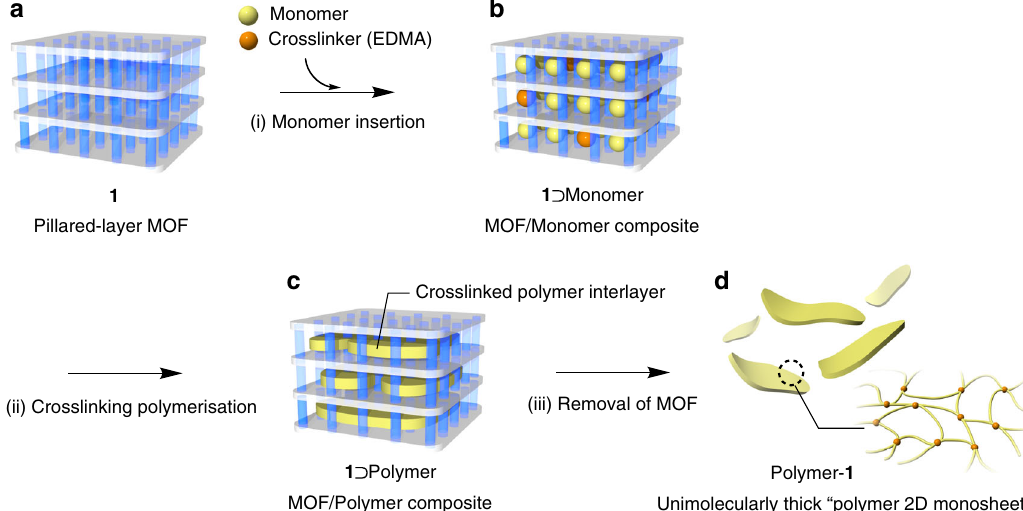
Fig. 1 Synthesis of polymer 2D monosheets using a pillared-layer MOF. a – d Schematically depicting the fabrication of ultimately thin polymeric sheets by crosslinking polymerisation in a MOF with 2D nanospaces. a Pillared-layer MOF, 1 . b 1 ⊃ Monomer composite. c 1 ⊃ Polymer composite. d Polymer- 1 with a unimolecularly thick polymer networking architecture.